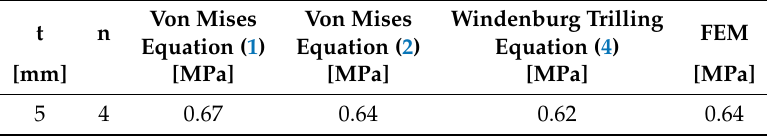
Table 4. Theoretical buckling pressure values.